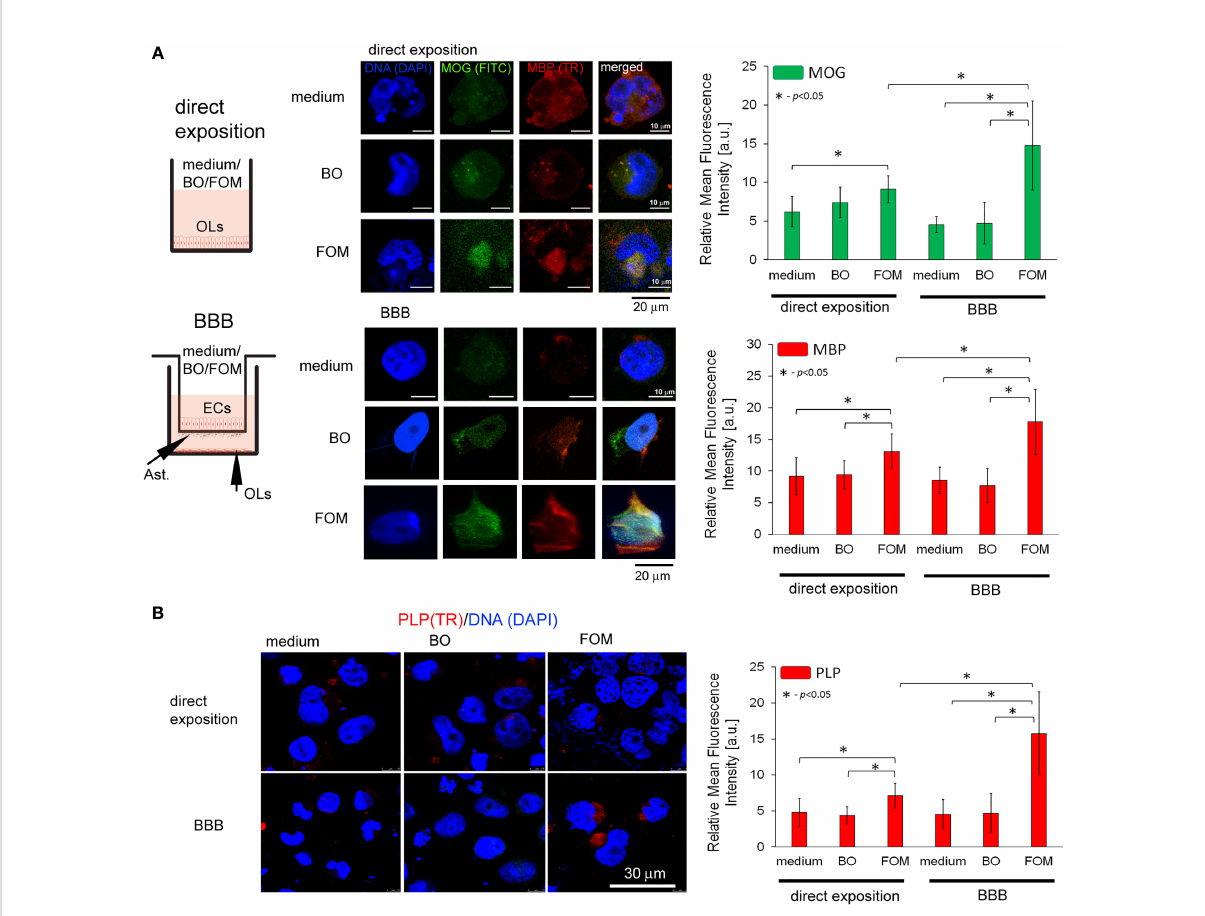
FIGURE 2 The supplementation of BBB cells by FOM, opposite to BO, during hOPC maturation enhanced MOG, PLP, and MBP synthesis by mature OLs. The use of the BBB increased the ability of mature OLs to synthesize myelin peptides compared to direct exposition of hOPCs to FOM during their maturation. ( A , left panel) Diagram of the experiment performed to characterize the role of the BBB exposed to FOM or BO and their effect on OPC differentiation into mature MBP/PLP/MOG-producing OLs. ( A , right panel) The ICC analysis of MOG (green pseudocolor) and MBP (red). (B) PLP immunocytochemical analysis. The data from the quantitative fl uorescence signal of protein analysis are presented as the relative mean fl uorescence intensity [arbitral units (a.u.)] ± SD from three independent experiments using at least 100 single cells for each test. The differences between medium/BO/FOM were calculated using the one-way ANOVA test and Scheffe ’ s test. The differences in the adequate groups between “ direct exposition ” and “ BBB model ” were calculated using the paired